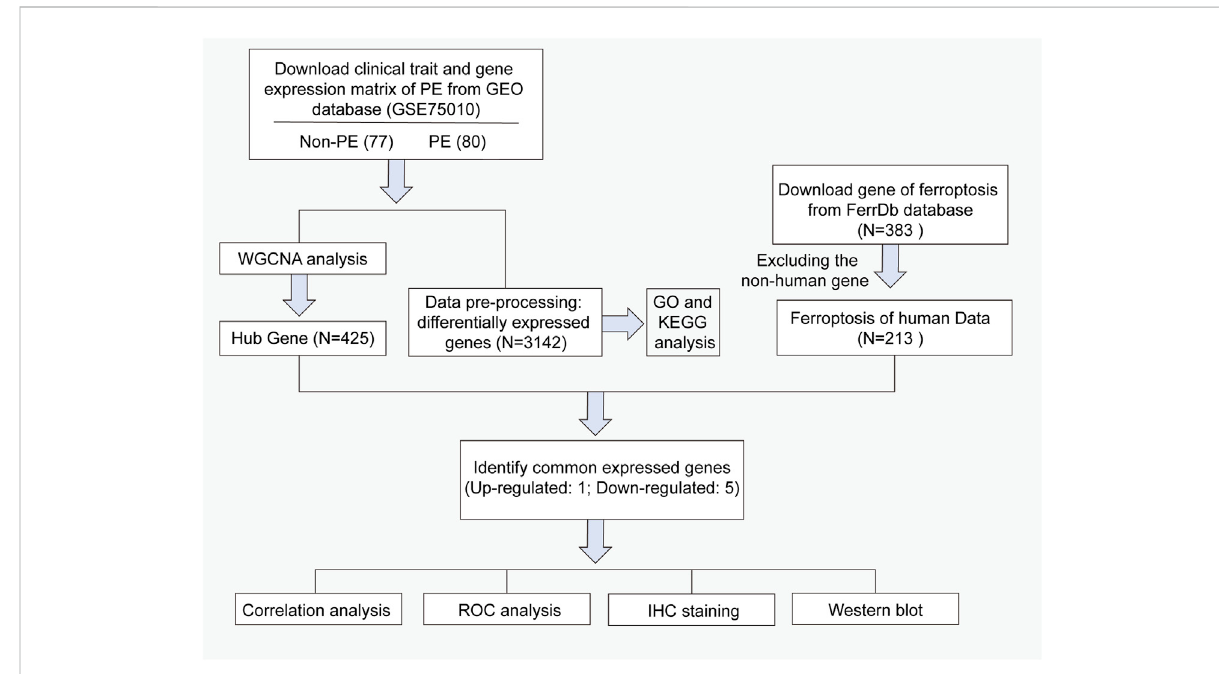
FIGURE 1 Work fl ow of searching hub genes in